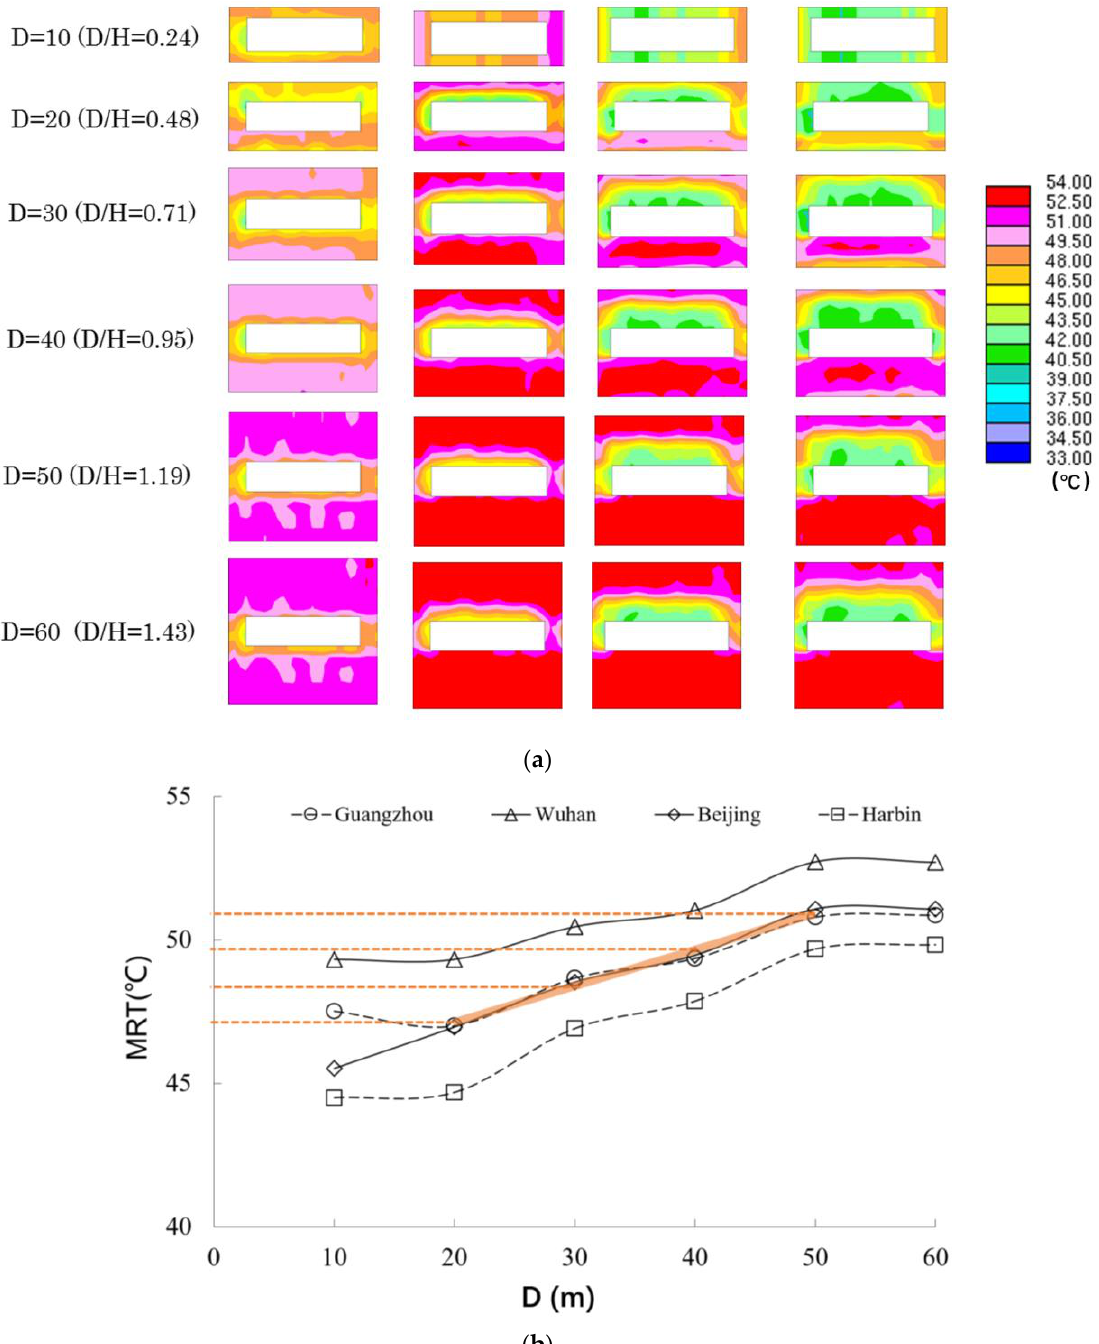
Figure 10. MRT results. ( a ) The distribution of MRT at 1.5 m, ( b ) The relationship between building distance and average MRT in four